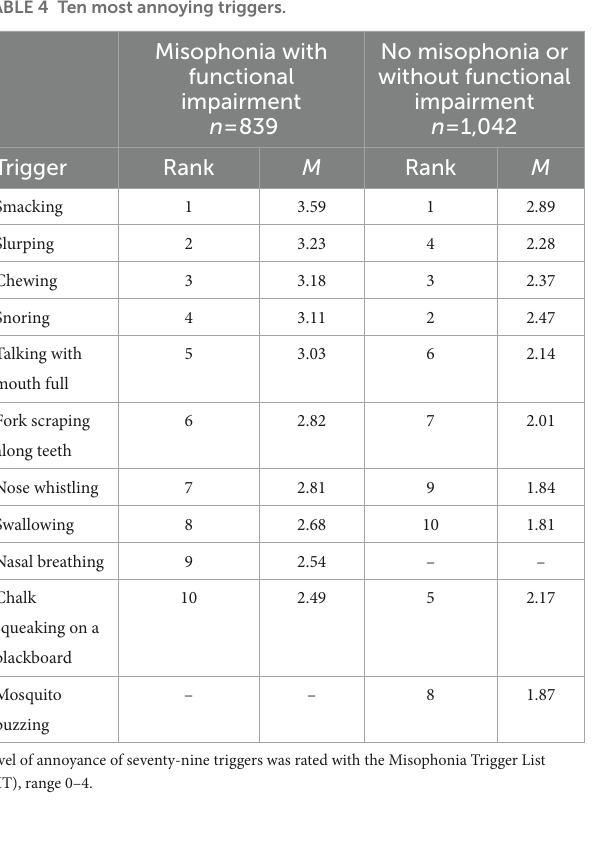
The results of the ROC analyses are presented in Table 5 with area under the curve values ranging from 0.81 (MQ subscale) to 0.87 (MAQ).